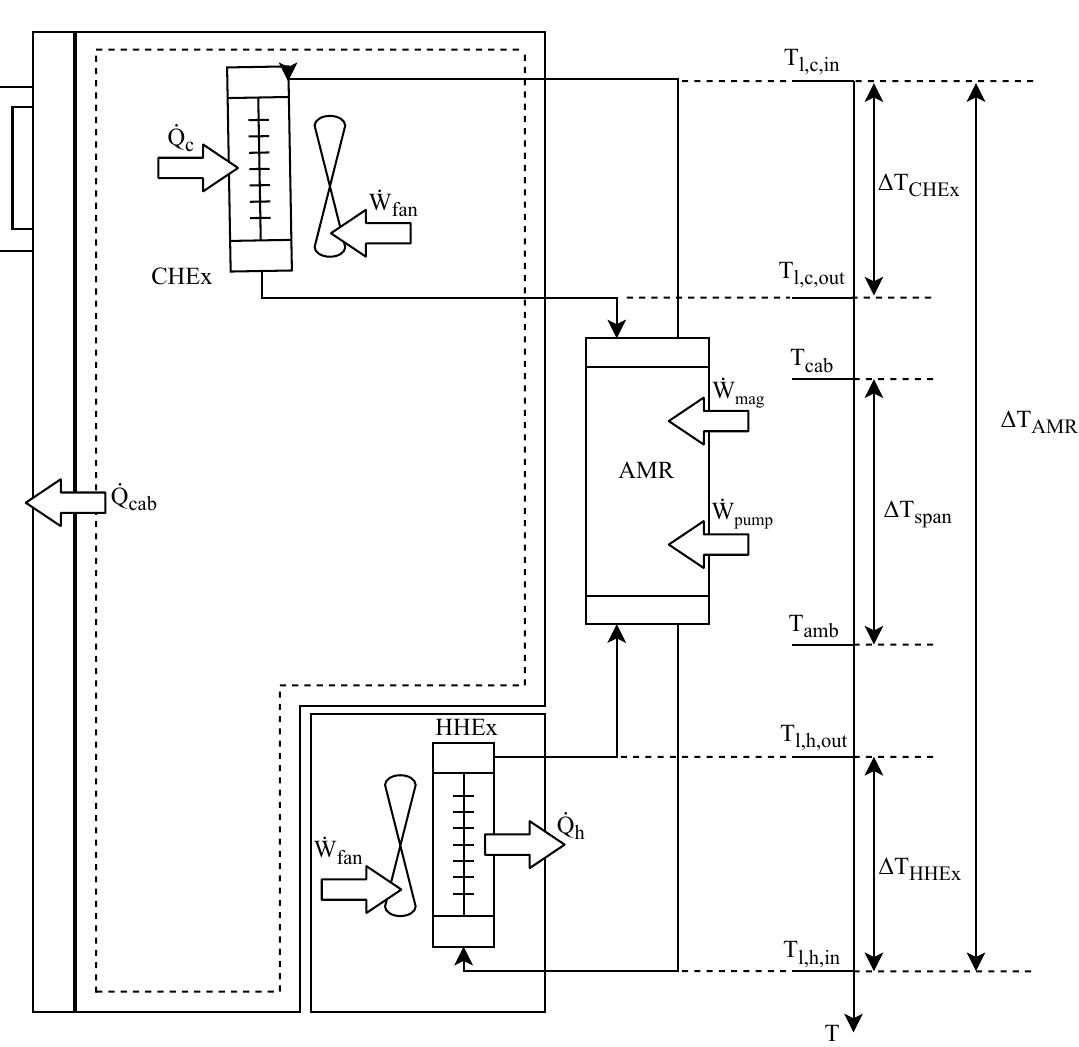
Figure 4. Schematic diagram of the mathematical models identifying the sub-systems of the experimental